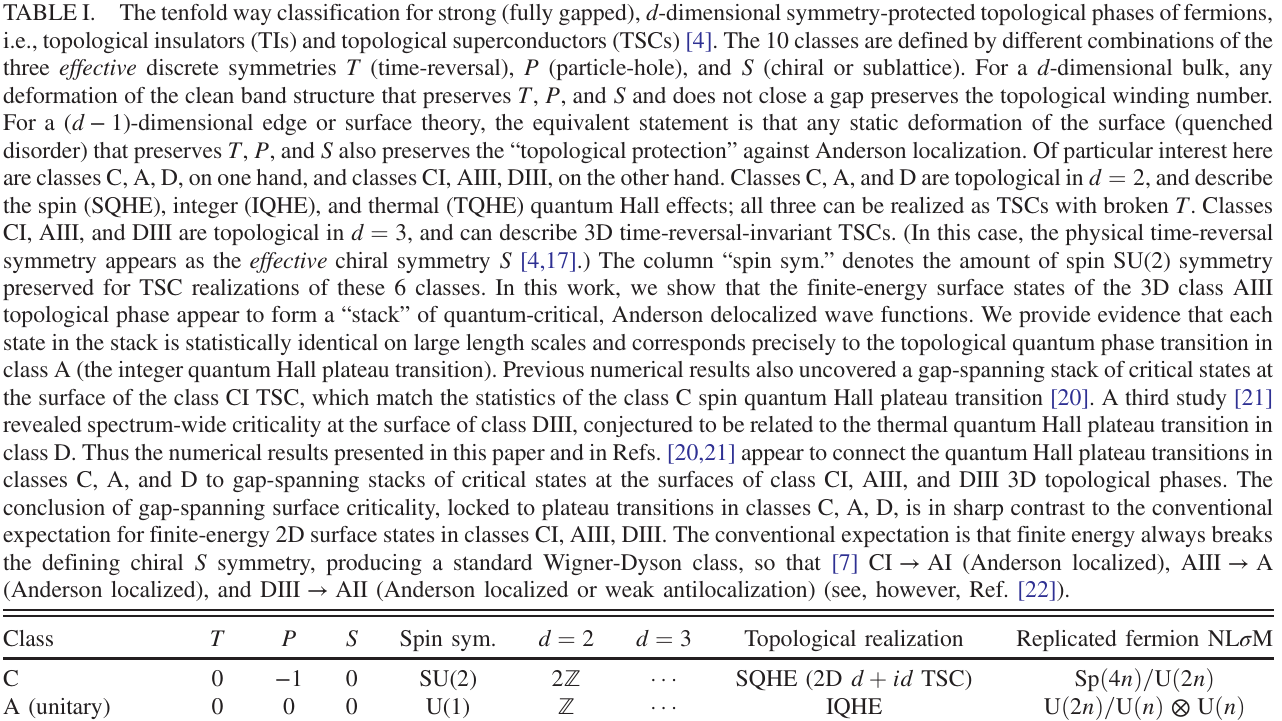
TABLE I. The tenfold way classification for strong (fully gapped), d -dimensional symmetry-protected topological phases of fermions, i.e., topological insulators (TIs) and topological superconductors (TSCs) [4]. The 10 classes are defined by different combinations of the three effective discrete symmetries T (time-reversal), P (particle-hole), and S (chiral or sublattice). For a d -dimensional bulk, any deformation of the clean band structure that preserves T , P , and S and does not close a gap preserves the topological winding number. For a ( d − 1 )-dimensional edge or surface theory, the equivalent statement is that any static deformation of the surface (quenched disorder) that preserves T , P , and S also preserves the “ topological protection ” against Anderson localization. Of particular interest here are classes C, A, D, on one hand, and classes CI, AIII, DIII, on the other hand. Classes C, A, and D are topological in d ¼ 2 , and describe the spin (SQHE), integer (IQHE), and thermal (TQHE) quantum Hall effects; all three can be realized as TSCs with broken T . Classes CI, AIII, and DIII are topological in d ¼ 3 , and can describe 3D time-reversal-invariant TSCs. (In this case, the physical time-reversal symmetry appears as the effective chiral symmetry S [4,17].) The column “ spin sym. ” denotes the amount of spin SU(2)